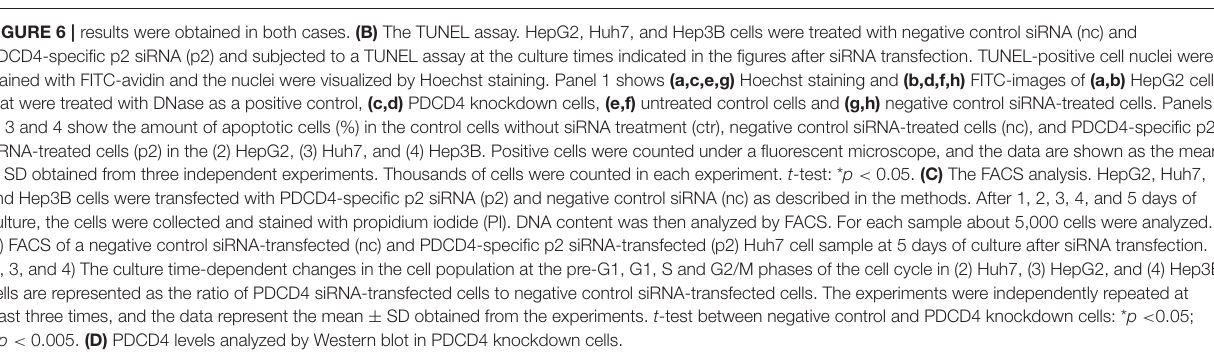
FIGURE 6 | results were obtained in both cases. (B) The TUNEL assay. HepG2, Huh7, and Hep3B cells were treated with negative control siRNA (nc) and PDCD4-specific p2 siRNA (p2) and subjected to a TUNEL assay at the culture times indicated in the figures after siRNA transfection. TUNEL-positive cell nuclei were stained with FITC-avidin and the nuclei were visualized by Hoechst staining. Panel 1 shows (a,c,e,g) Hoechst staining and (b,d,f,h) FITC-images of (a,b) HepG2 cells that were treated with DNase as a positive control, (c,d) PDCD4 knockdown cells, (e,f) untreated control cells and (g,h) negative control siRNA-treated cells. Panels 2, 3 and 4 show the amount of apoptotic cells (%) in the control cells without siRNA treatment (ctr), negative control siRNA-treated cells (nc), and PDCD4-specific p2 siRNA-treated cells (p2) in the (2) HepG2, (3) Huh7, and (4) Hep3B. Positive cells were counted under a fluorescent microscope, and the data are shown as the mean ± SD obtained from three independent experiments. Thousands of cells were counted in each experiment. t -test: * p < 0.05. (C) The FACS analysis. HepG2, Huh7, and Hep3B cells were transfected with PDCD4-specific p2 siRNA (p2) and negative control siRNA (nc) as described in the methods. After 1, 2, 3, 4, and 5 days of culture, the cells were collected and stained with propidium iodide (PI). DNA content was then analyzed by FACS. For each sample about 5,000 cells were analyzed. (1) FACS of a negative control siRNA-transfected (nc) and PDCD4-specific p2 siRNA-transfected (p2) Huh7 cell sample at 5 days of culture after siRNA transfection. (2, 3, and 4) The culture time-dependent changes in the cell population at the pre-G1, G1, S and G2/M phases of the cell cycle in (2) Huh7, (3) HepG2, and (4) Hep3B cells are represented as the ratio of PDCD4 siRNA-transfected cells to negative control siRNA-transfected cells. The experiments were independently repeated at least three times, and the data represent the mean ± SD obtained from the experiments. t -test between negative control and PDCD4 knockdown cells: * p < 0.05; ** p < 0.005. (D) PDCD4 levels analyzed by Western blot in PDCD4 knockdown